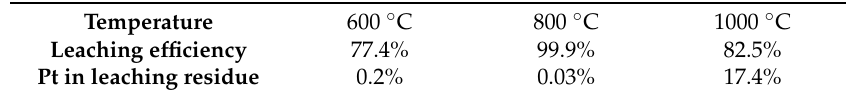
Table 2. The leaching behavior of platinum (Pt) at different calcination temperature (Leaching condition: